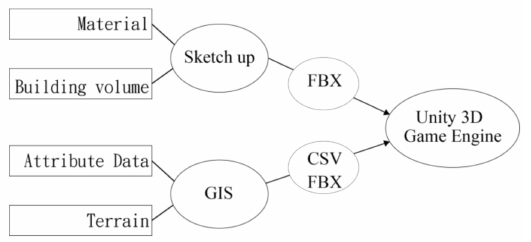
Figure 7. Concept map of the game engine that integrates historical building models with GIS